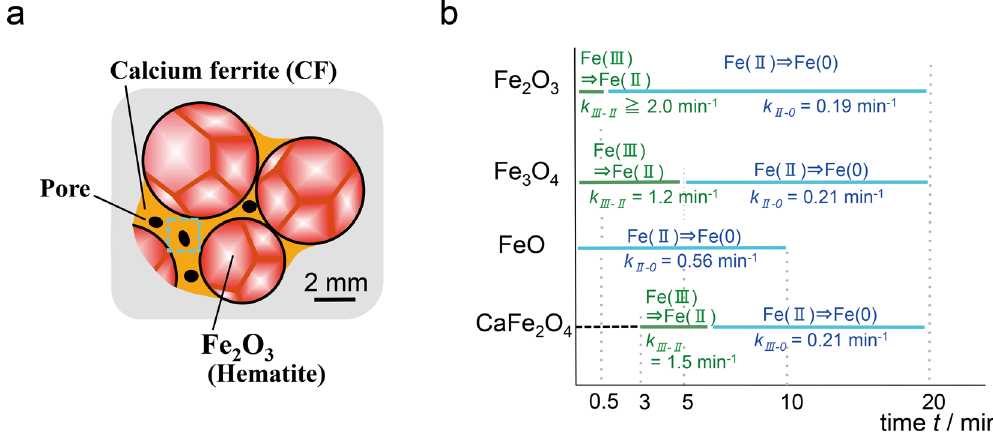
Figure 1. Reduction of iron ore sinters. ( a ) Schematic of an iron ore sinter before reduction. ( b ) Iron reduction rates for the Ca–Fe–O phases corresponding to the main phases in the sinters, which were measured using bulk powder samples in the previous studies 28,29